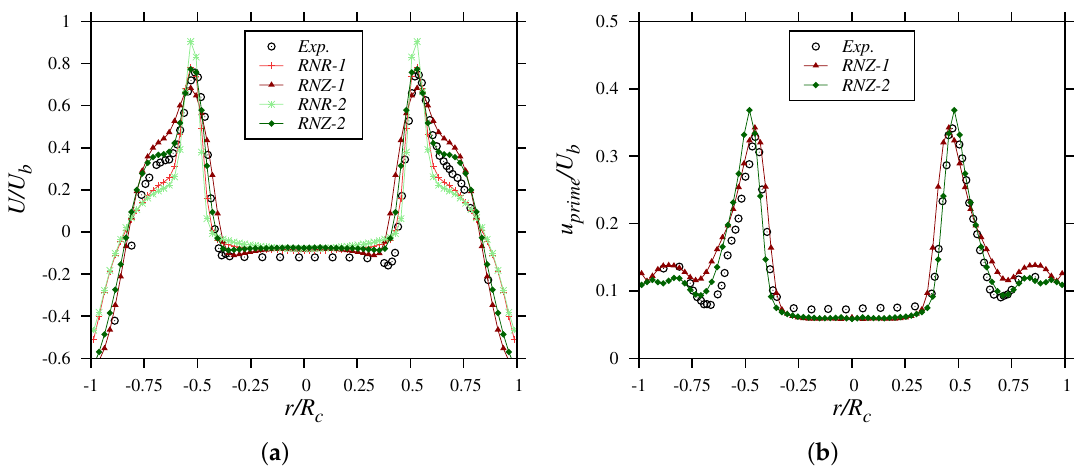
Figure 3. Mean and RMS profiles at x = 20 mm: ( a ) mean axial velocity; ( b ) RMS axial velocity fluctuation.